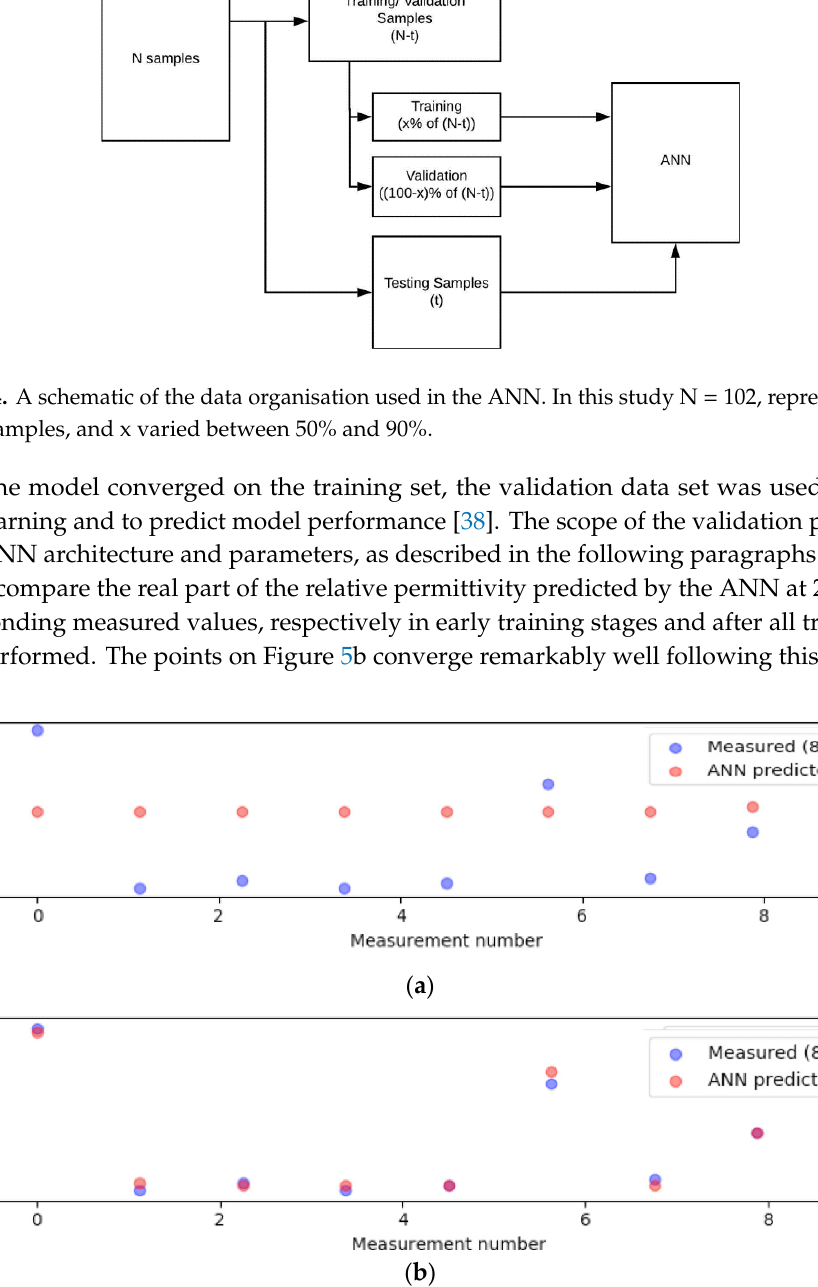
Figure 6. A schematic diagram showing training, validation and testing sequence of the ANN. The training of the ANN was performed using a multilayer perceptron regressor (MLPRegressor) algorithm coded in Python [39]. Different configurations were tested and the best results were obtained with an architecture consisting of 5 successive layers, with 200, 400, 600, 400, 200 hidden nodes in each layer respectively (refer to Figure 3, starting from left). The activation function used was the rectified linear unit (ReLU), with the solver (optimisation algorithm) selected